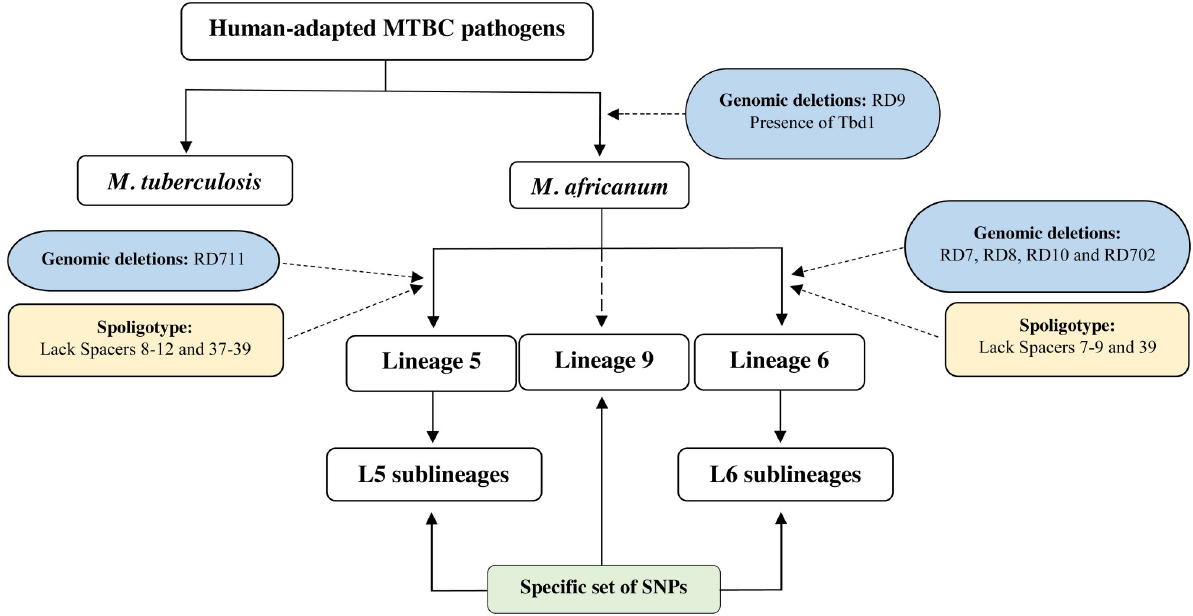
Fig 3. Genetic identity of M . africanum lineages. Represented are the genetic markers that distinguish M . africanum from M . tuberculosis and lineages 5, 6, and 9 within M . africanum . Of note, since no robust genetic deletions allowing the classification of L9 have been reported, the identification of this lineage is based in specific SNPs. L, lineage; MTBC, Mycobacterium tuberculosis complex; RD, region of difference; SNP, single nucleotide polymorphism.